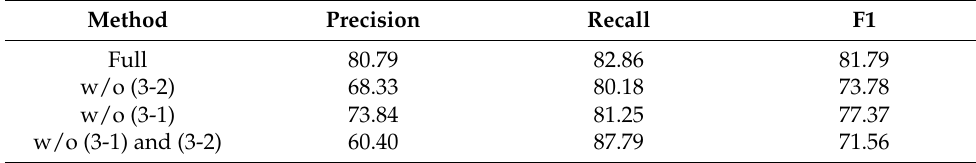
Table 5. Ablations on the ADE dataset.